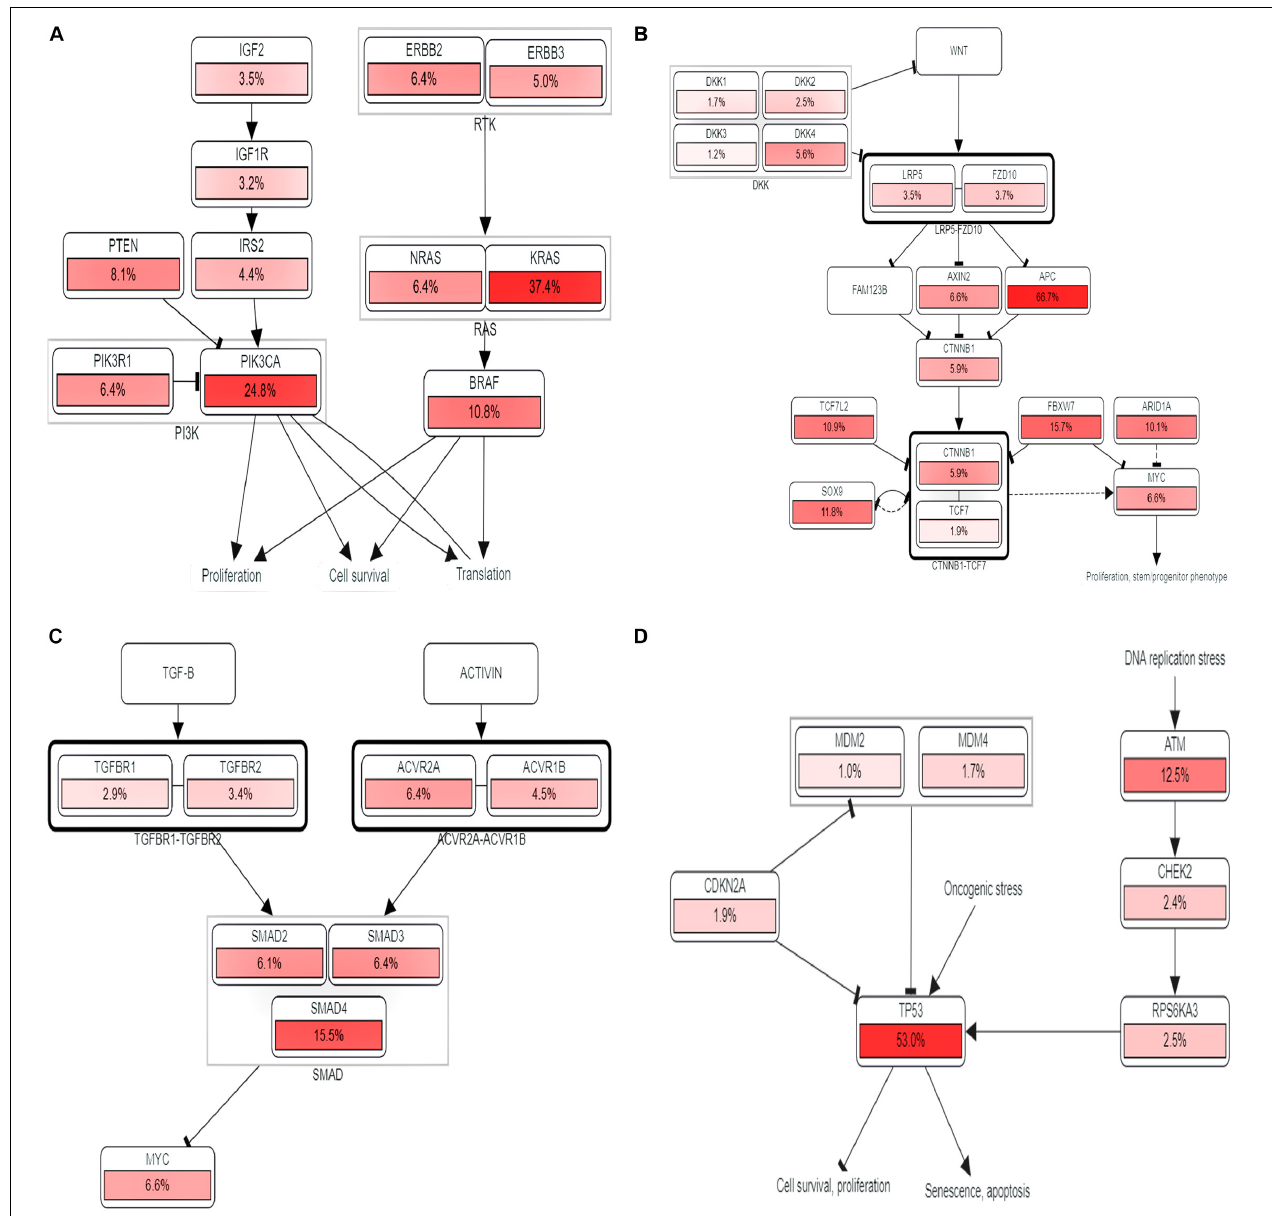
FIGURE 7 | Pathway analysis. (A–D) Impact of COL11A1 and associated gene in regulating alteration frequency of (A) RTK-RAS-PI3K signaling pathway, (B) Wnt signaling pathway, (C) TGF- β signaling pathway, (D) TP53